Question: Looking at the figure, what chart type is it?
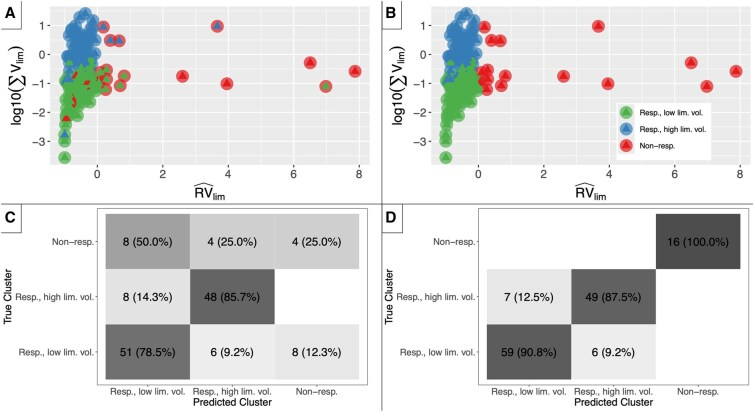
Answer: heatmap